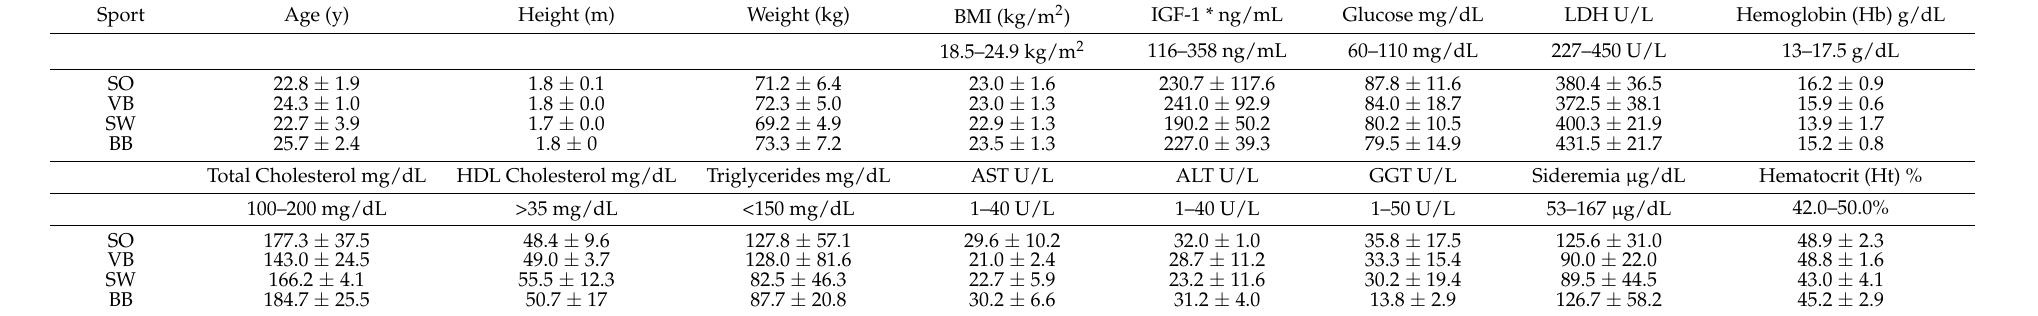
Table 1. Clinical–biochemical characterization of enrolled